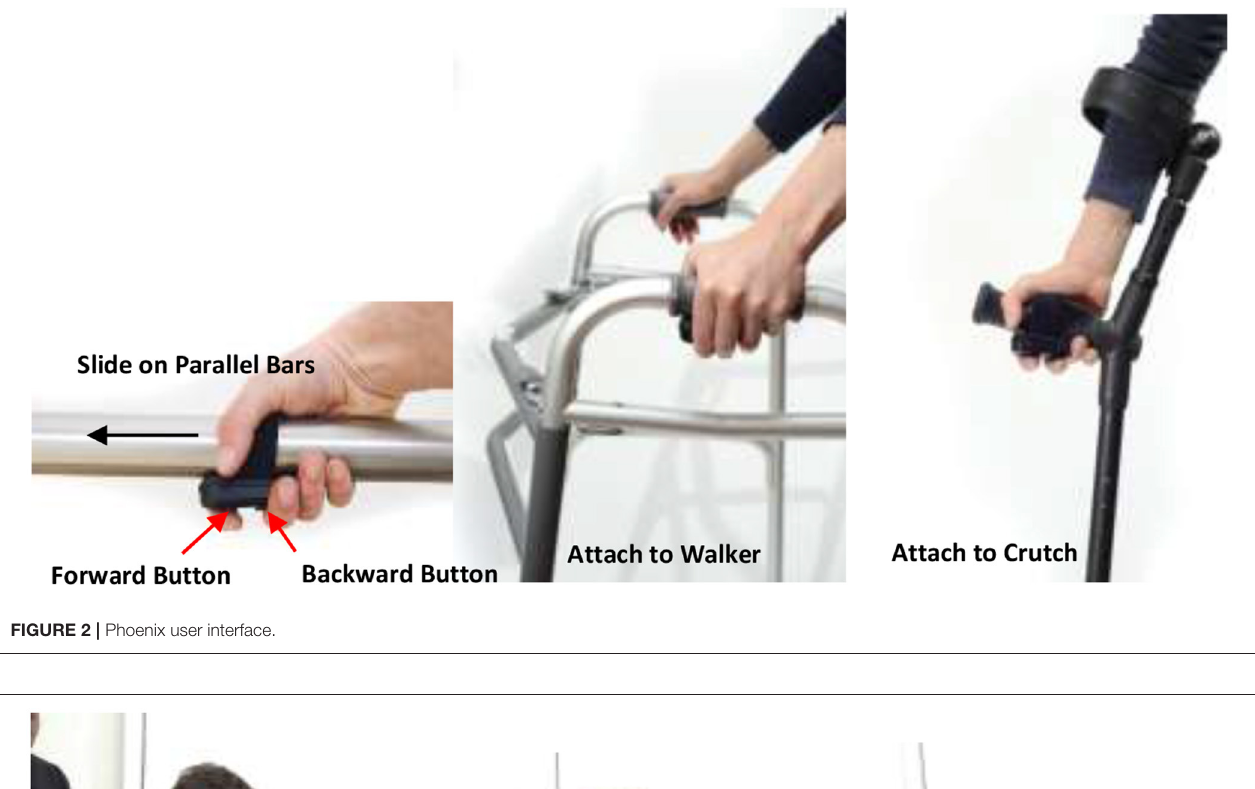
FIGURE 2 | Phoenix user interface.